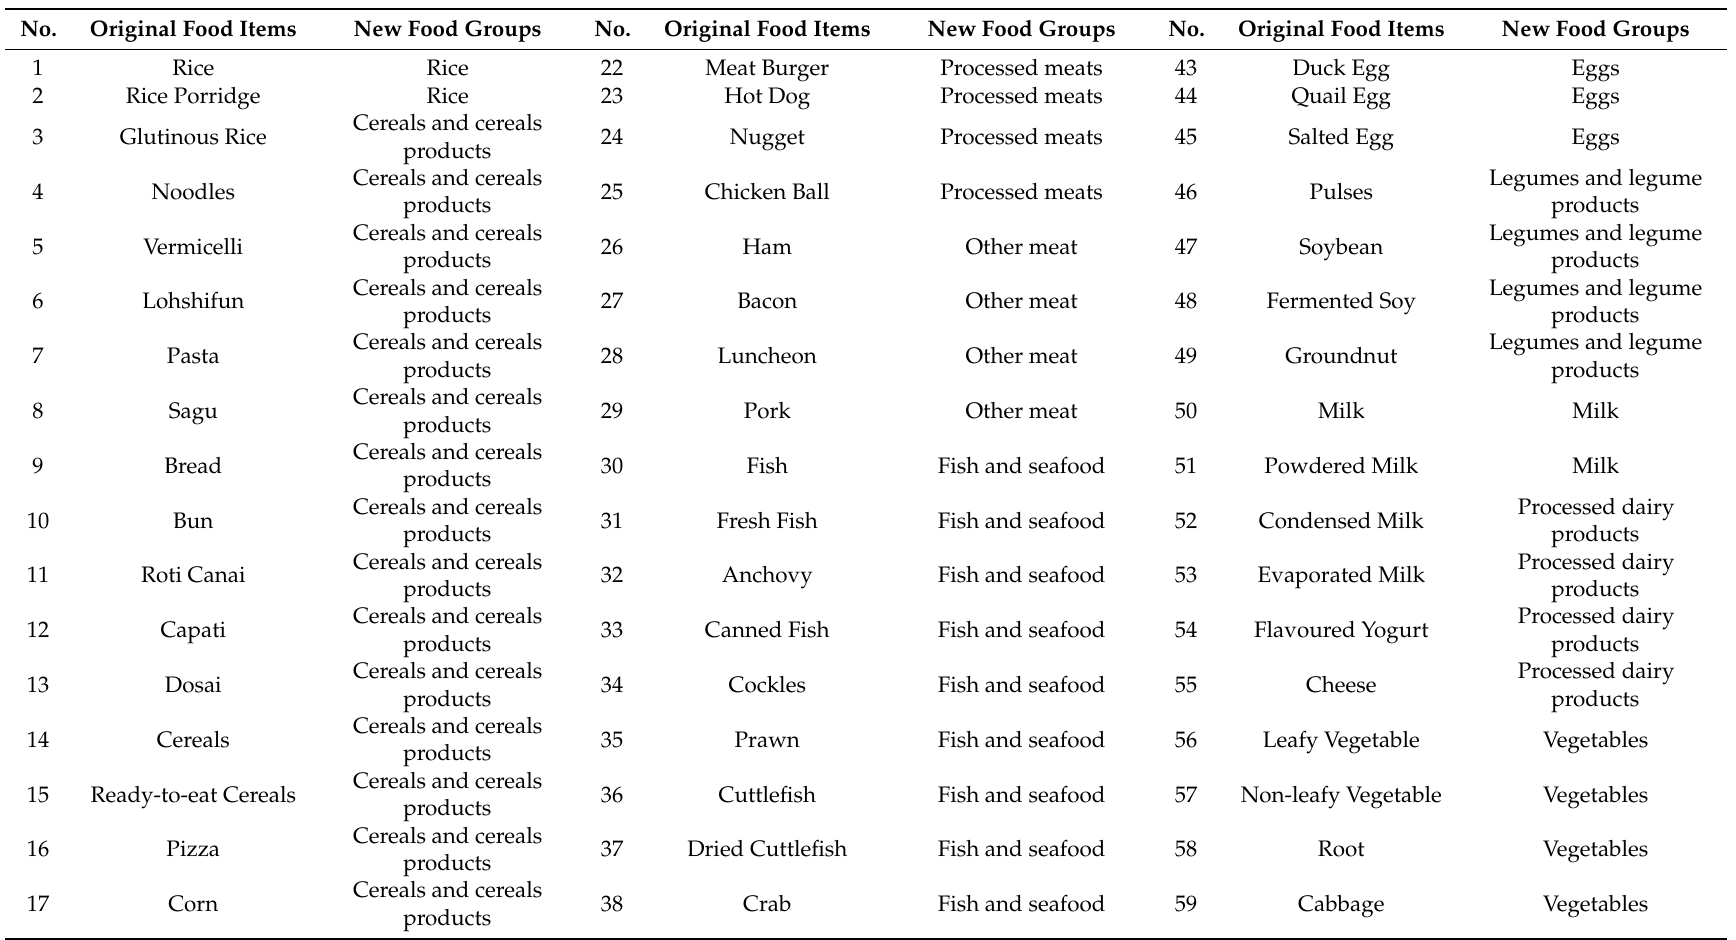
Table A1. List of 126 food items grouped into 17 food item